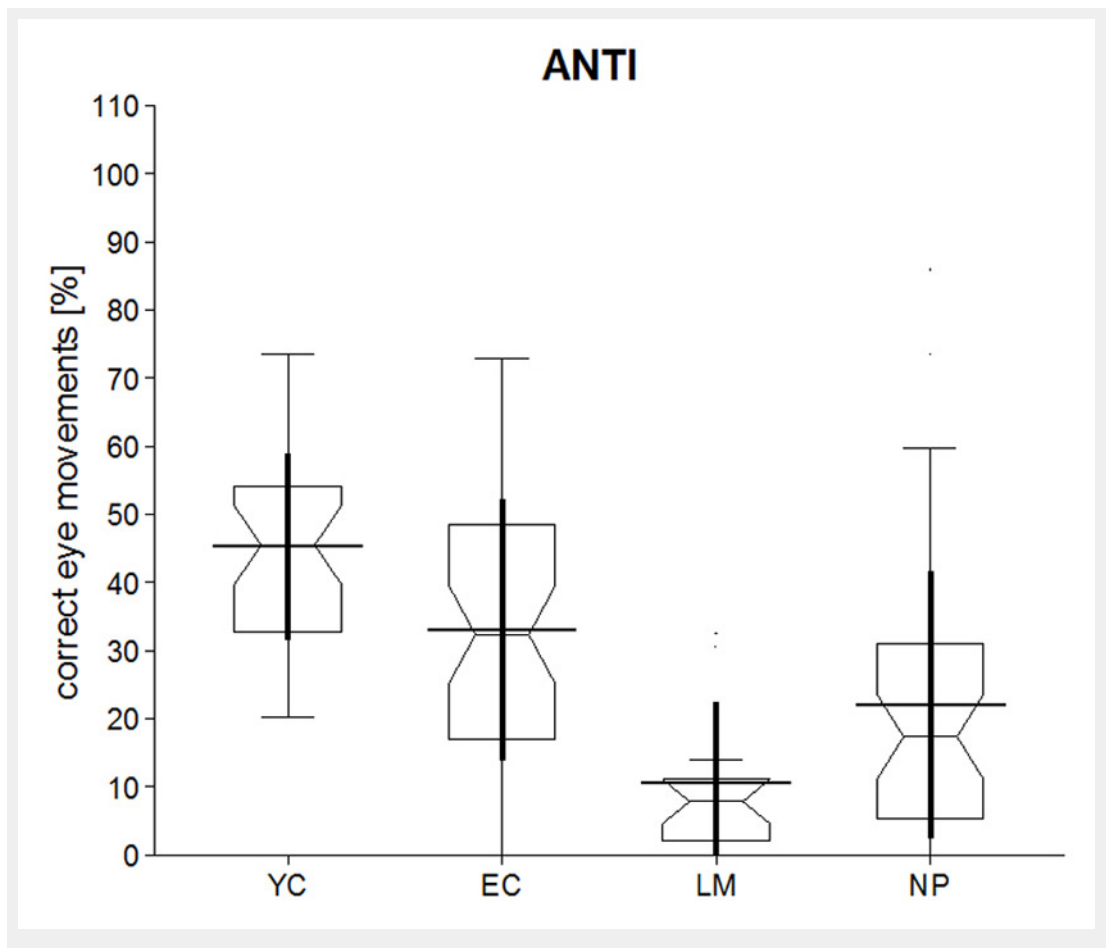
Figure 2 Evaluation of all antisaccades for all groups. EC = elderly comparison group; LM = patients at the Department of Legal Medicine; NP = patients at the Department of Neurology; YC = young comparison